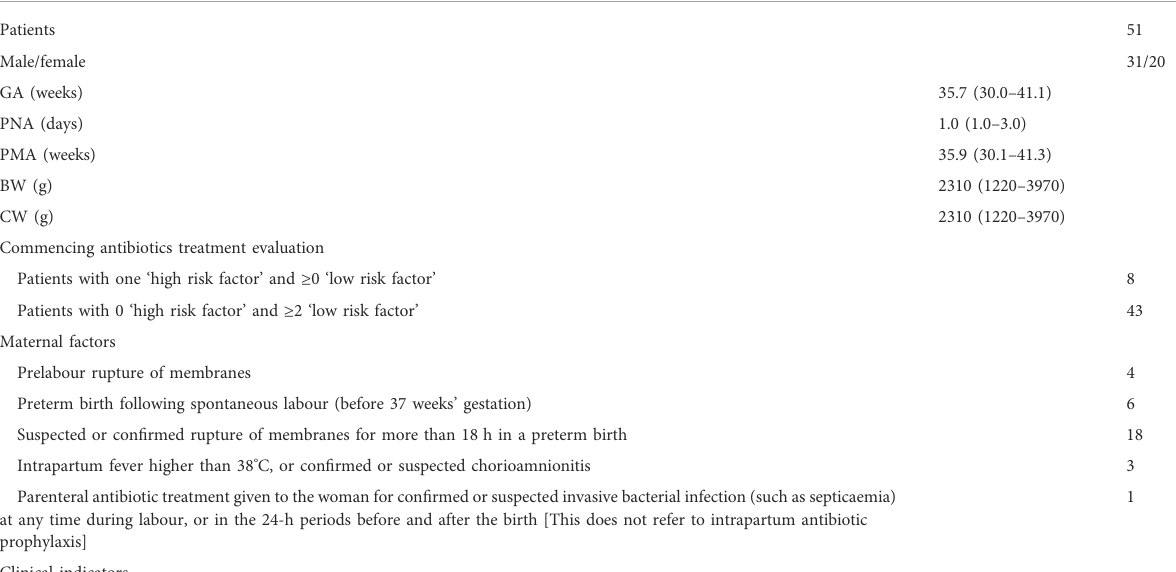
TABLE 1 Baseline characteristics of 51 neonates in effectiveness and safety